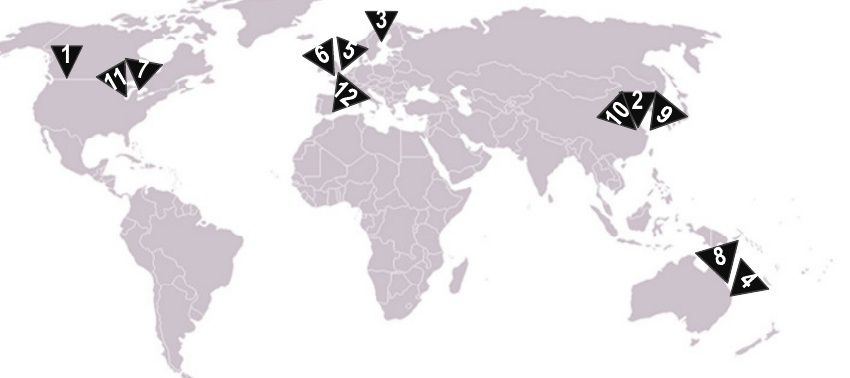
Figure 5. World map showing the location of the projects